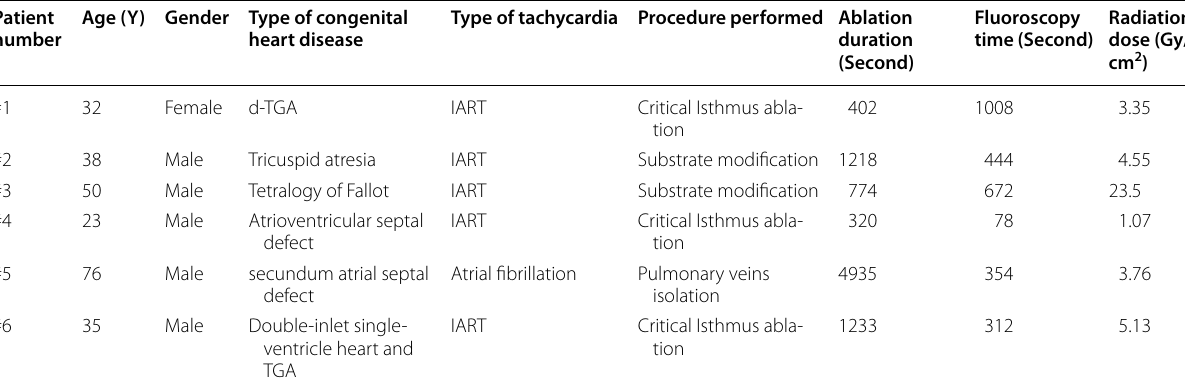
IART intra-atrial re-entrant tachycardia, d-TGA dextro-transposition of the great arteries